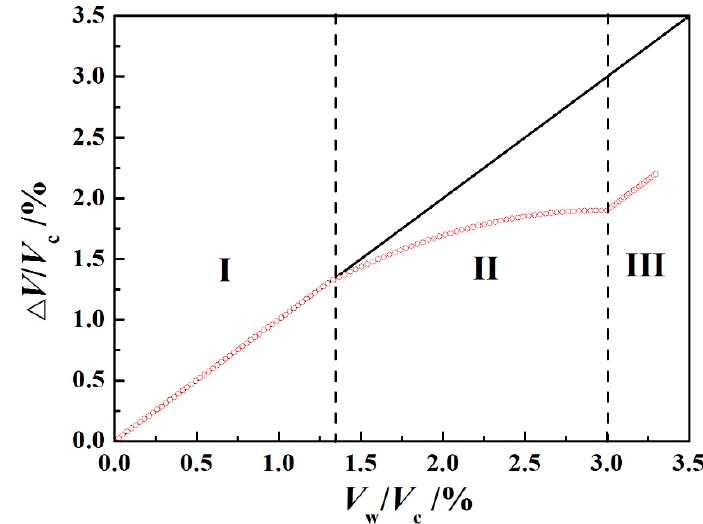
Figure 5. Evolution of relative swelling as a function of water uptake of free polymers at 30 °C. Δ V is the swelling volume of the polymer system, consisting of polymers, water, and air, V w is the volume of water entering the polymers, and V c is the volume of dry polymers [64].